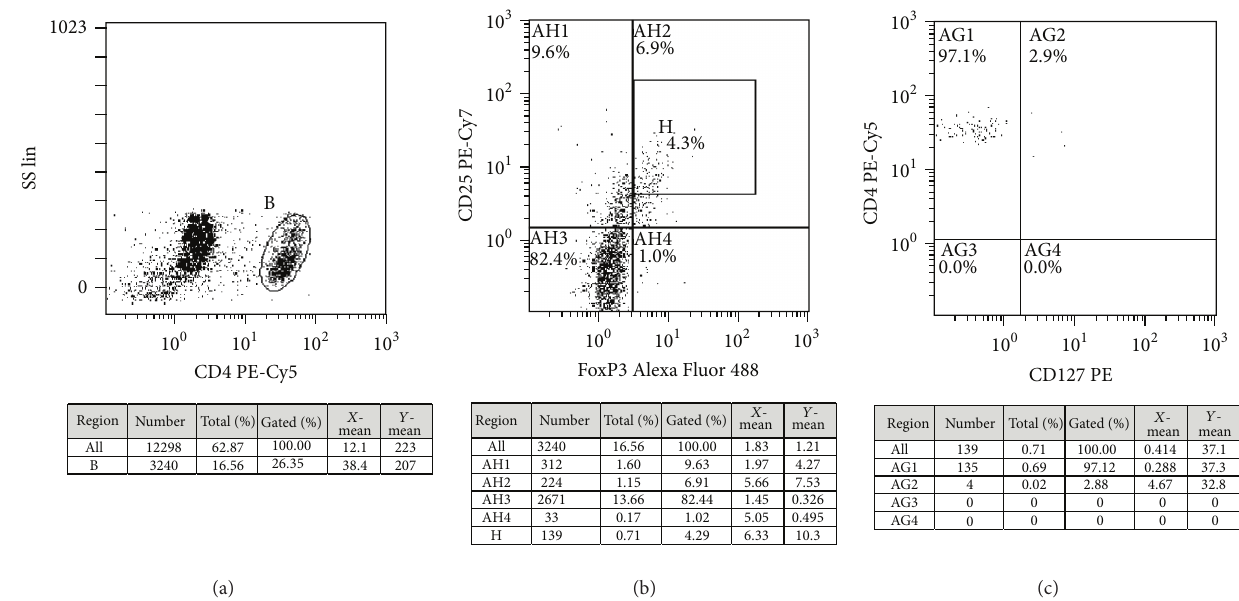
Figure 1: FoxP3 Tregs gating strategy. Example result obtained for a single patient before ASIT. PBMC was stained with combination of surface antigens (anti-CD4, anti-CD25, and anti-CD127) and intracellularly with anti-FoxP3. For analysis, CD4 positive cells from PBMC were gated ((a) dot plot SS versus CD4, gate B) and analyzed for CD25 and FoxP3 expression ((b) dot plot CD25 versus FoxP3 for B gate); cells in H gate were considered Tregs. The expression of CD127 in Tregs population was analyzed ((c) dot plot CD4 versus CD127 for H